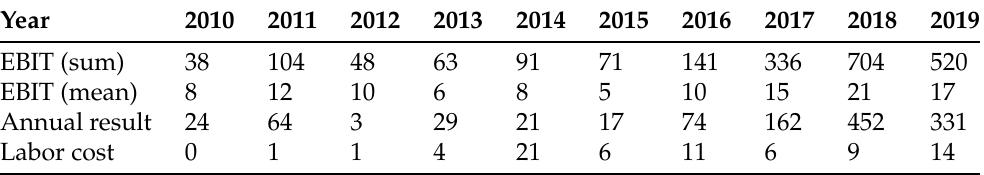
Table 15. The sum of all companies’ EBIT and average EBIT. The sum of the annual profit after tax and the sum of the wage costs. Numbers in NOK